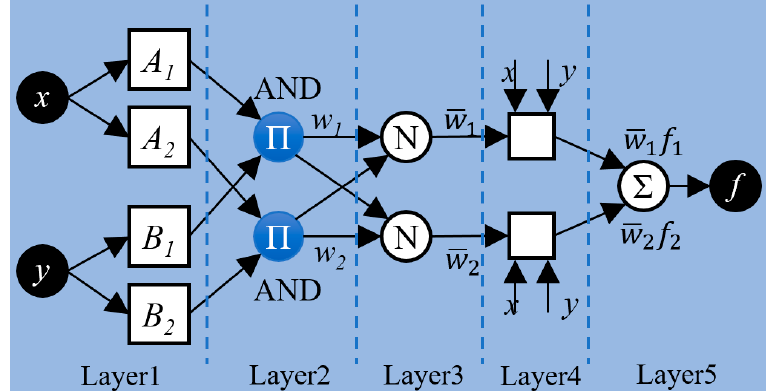
Figure 2. Network structure of an Adaptive Neuro Fuzzy Inference System (ANFIS) model.